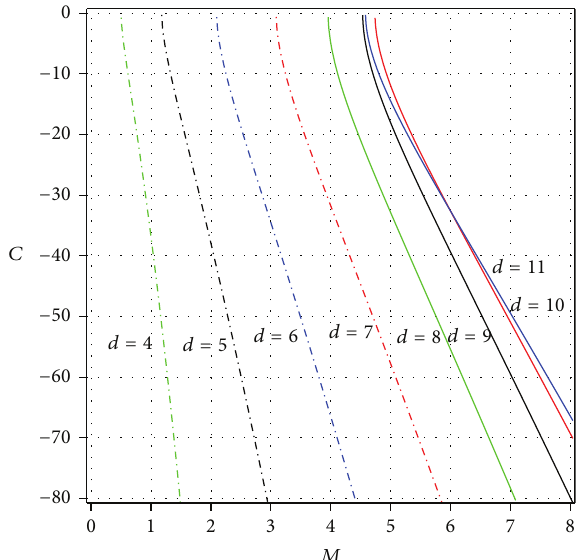
Figure 9: Black hole heat capacity as a function of mass with GUP ∗∗ and for different numbers of space-time dimensions with 𝛼 = 1 and 𝛽 = 0.01 .